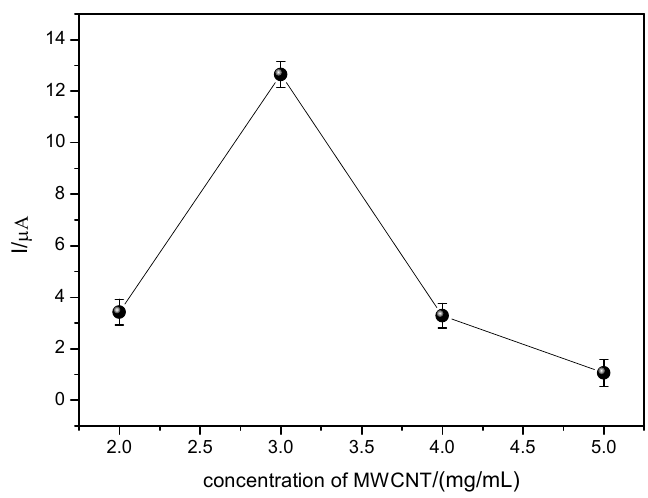
Figure 11. Variation of the Ipa/μA of Ethinyl estradiol as a function of the concentration of MWCNT. Buffer solution Phosphate 0.1 mol L −1 , pH 7.0. Concentration of 175 μmol L −1 of Ethinyl estradiol.